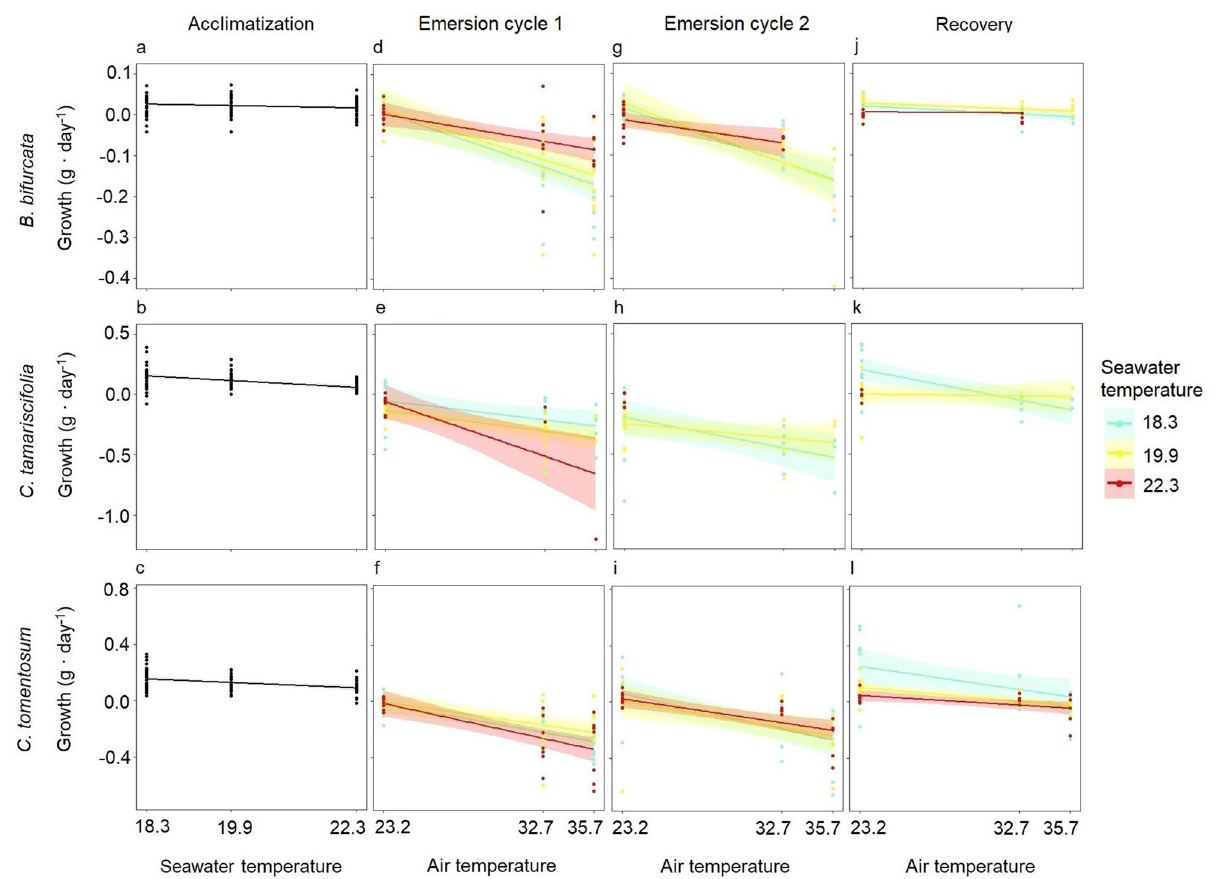
Figure 3. Trends in macroalgal growth as a function of temperature treatments (air temperature: control ~ 23.2 °C, atmospheric heatwave ~ 32.7 °C and extreme atmospheric heatwave ~ 35.7 °C; seawater temperature: control ~ 18.3 °C, marine heatwave ~ 19.9 °C and extreme marine heatwave ~ 22.3 °C) after acclimatization to seawater temperature ( a – c ), after emersion cycles ( d – i ) and after recovery ( j – l ) in the laboratory experiment. The points represent replicates and the smoothed curves are the data fitted by GLMs with a confidence interval of 95%. Note that due to an insufficient number of replicates, the effect of the highest air temperature (35.7 °C) on the growth of B. bifurcata after the second emersion cycle was not formally modelled. Likewise, the effect of air temperature on the growth of C. tamariscifolia after the two emersion cycles was not formally